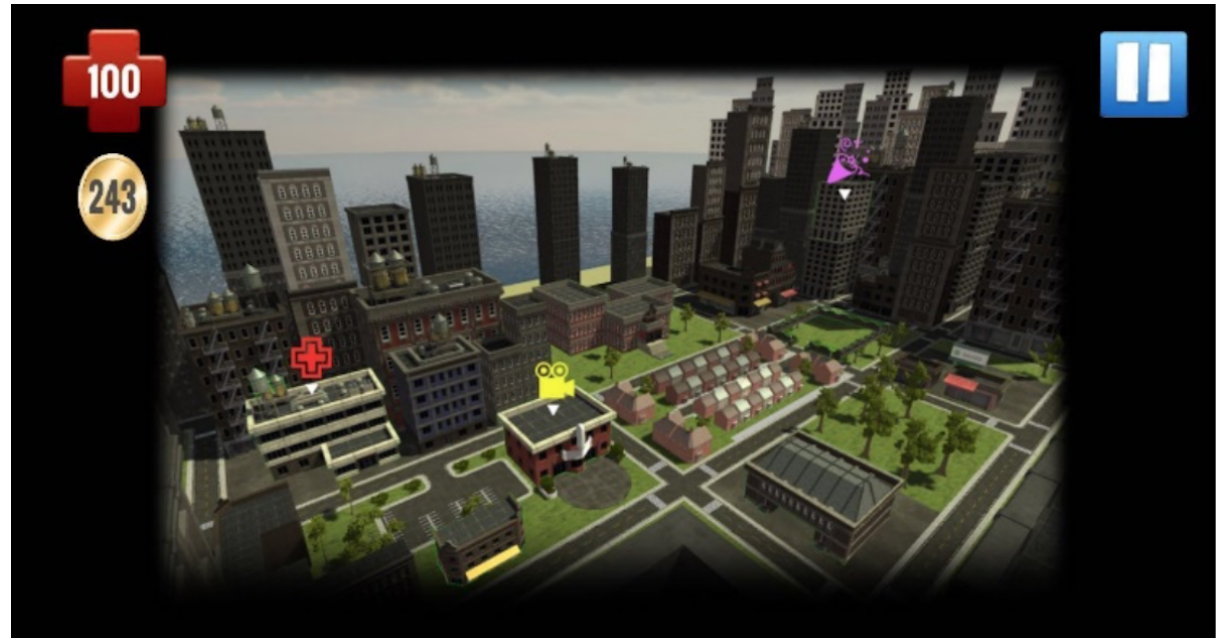
Figure 3. Screenshot of Studenton city